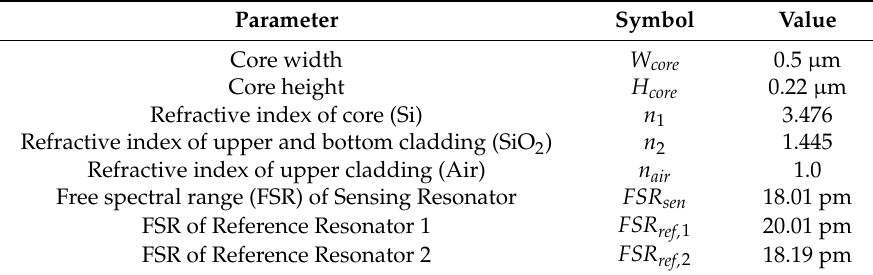
Table 1. Design parameters of the cascaded resonators.